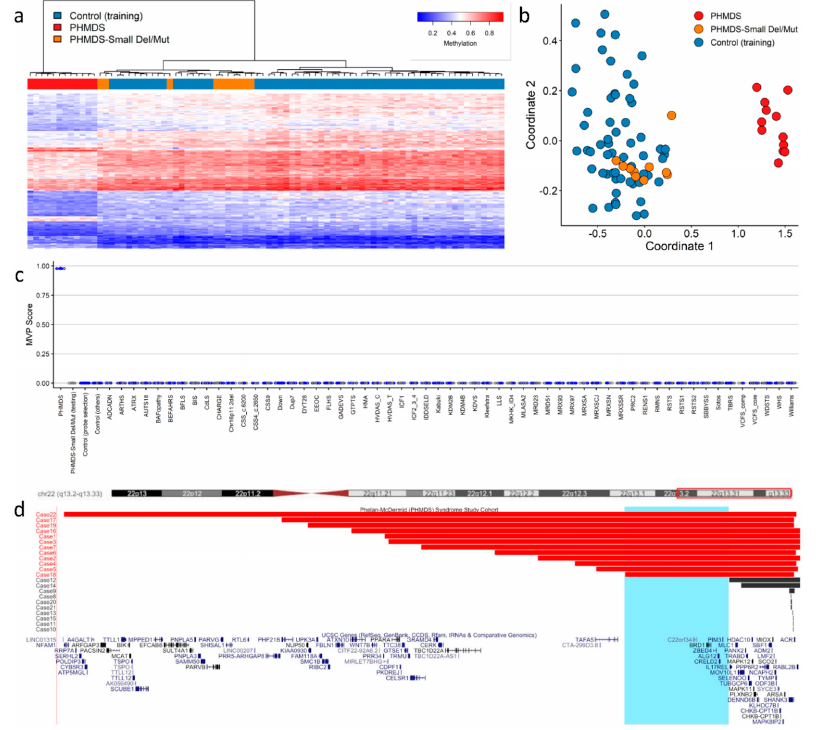
Figure 1. Phelan − McDermid syndrome (PHMDS) episignature demonstrating the critical BRD1 region: ( a ) Euclidean hierarchical clustering (heatmap); each column represents a single PHMDS case or control, each row represents one of the CpG probes selected for the episignature. This heatmap shows clear separation between large deletion (2 − 6 Mb in size) PHMDS cases (red) from controls (blue). Smaller deletions (0.01 − 1 Mb) and intragenic SHANK3 gene variants (Small Del/Mut) (or- ange) are shown to segregate with controls. ( b ) Multidimensional scaling (MDS) plot shows segre- gation of large deletion PHMDS cases from both controls and Small Del/Mut cases. ( c ) Support vec- tor machine (SVM) classifier model. Model was trained using the selected probes for the PHMDS episignature, 75% of controls and 75% of other neurodevelopmental disorder samples (blue). The remaining 25% of controls and 25% of other disorder samples were used for testing (grey). Plot shows the large deletion PHMDS cases with a methylation variant pathogenicity (MVP) score close to 1 compared with all other samples, showing the specificity of the classifier and episignature. ( d ) PHMDS deletions illustrating the critical region of interest associated with DNA methylation ep- isignature. The horizontal red bars represent large deletion PHMDS cases associated with the pres- ence of a distinct episignature. The horizontal black bars represent Small Del/Mut cases that do not have a distinct DNA methylation episignature. Highlighted in light blue is the common critical re- gion of interest (Chr22:49,228,863 − 50,429,645) of deletions associated with the episignature. The common region of interest contains the candidate BRD1 gene. Cytogenetic bands and known genes are presented in this figure using the UCSC genome browser [82] 2009 (GRCh37/hg19) genome build. Figure adapted with permission from Schenkel et al . [46].